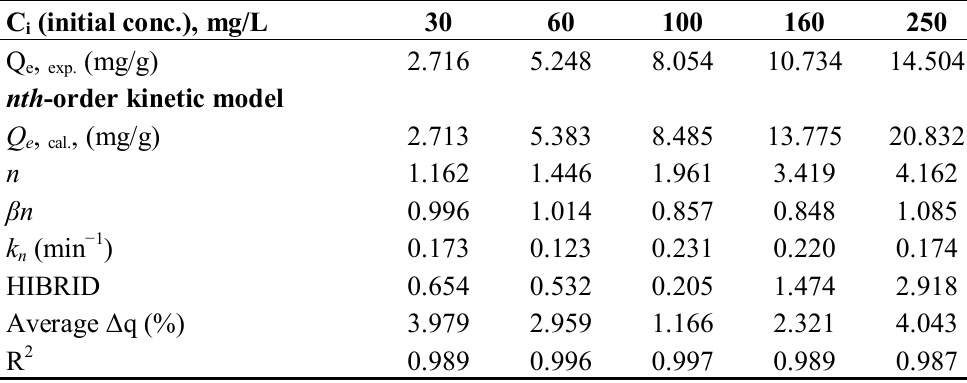
Table 3. Comparison of adsorption kinetic models at 10 °C